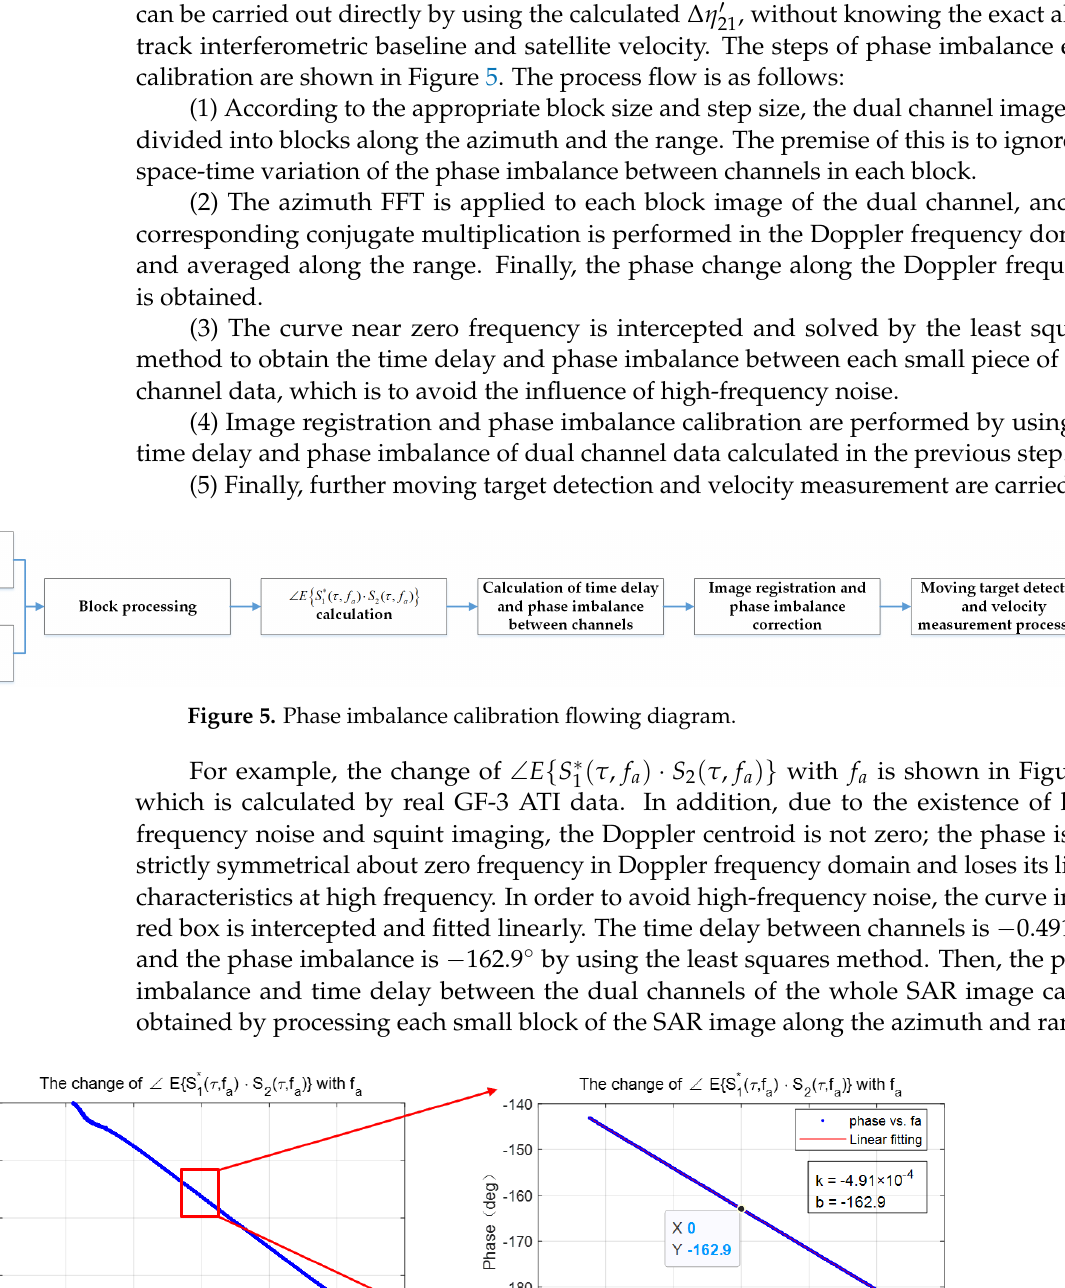
Figure 6. The change of ∠ E { S ∗